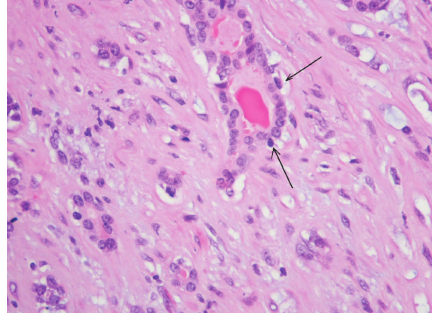
Figure 4: Tumor, inner glandular layer, and outer myoepithelial layer (hematoxylin eosin, original magnification × 400).